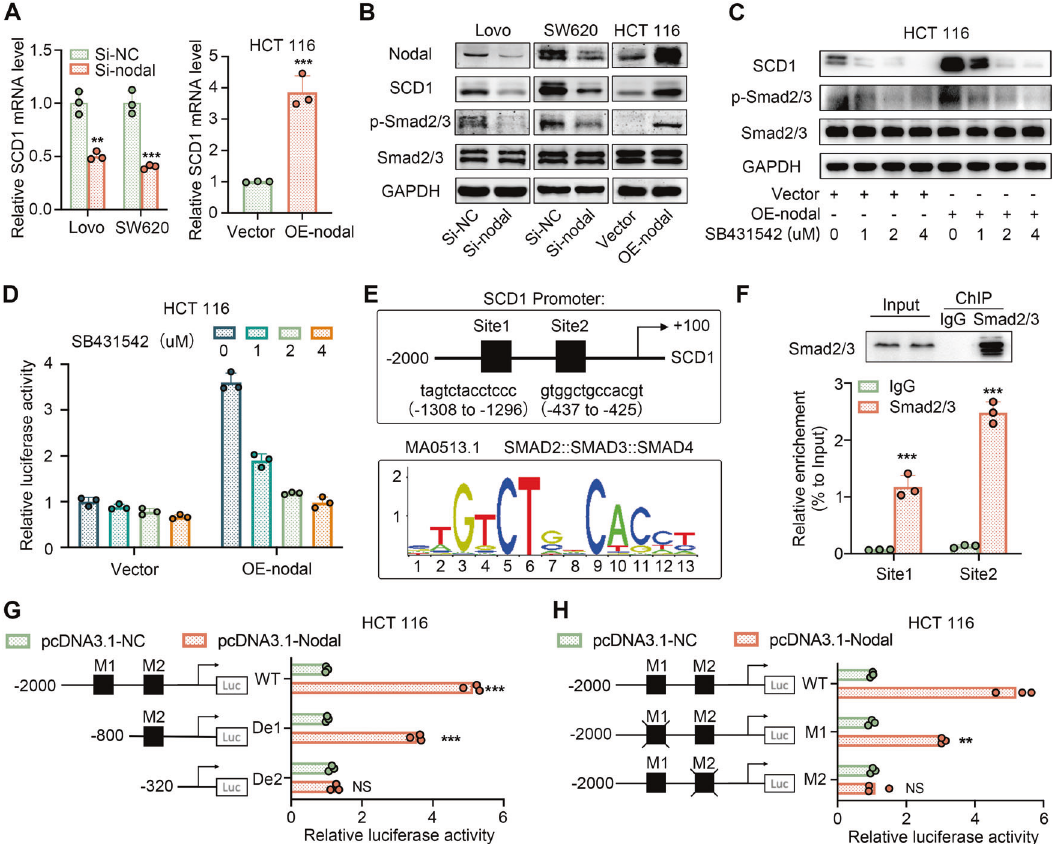
Fig. 6 Nodal regulated SCD1 transcription through Smad2/3. A qRT-PCR analysis of SCD1 mRNA after Nodal down-regulation and up- regulation. B Western blot analysis of the protein expression of Nodal, SCD1, Smad2/3 and p-Smad2/3 after Nodal down-regulation and up- regulation. C Western blot analysis of the protein expression of Nodal, SCD1, Smad2/3 and p-Smad2/3 in vector and oe-Nodal HCT116 cells treated with different concentrations of SB431542. D A dual luciferase reporter assay system was used to measure the activity of